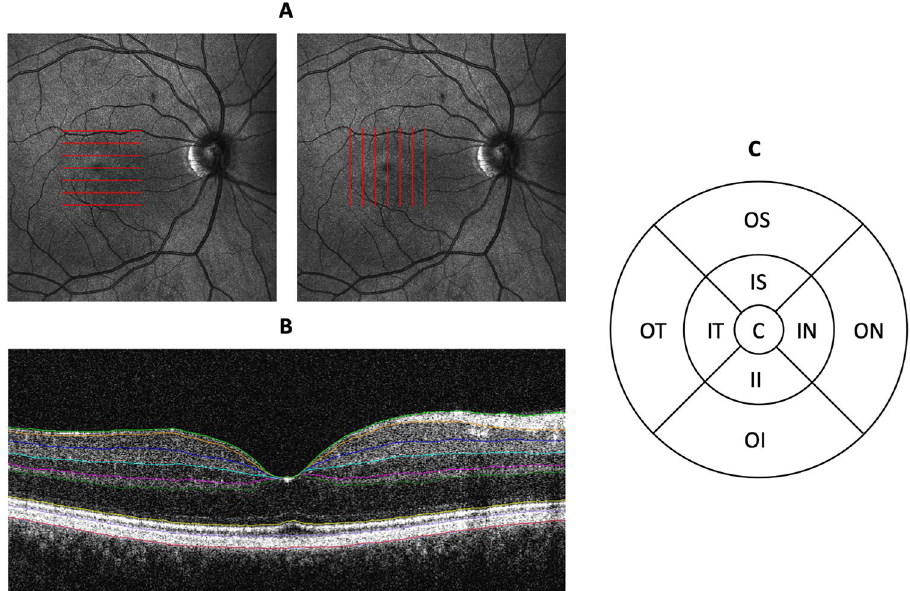
Figure 1. Macular volumetric OCT measurements. ( A ) Schematic representation of the B-scan orientation used in the macular volumetric measurements in the right eye. ( B ) An example B-scan showing the individual retinal layer segmentation. ( C ) Schematic representation of the ETDRS sectors. C central circle, II inner inferior, OI outer inferior, IN inner nasal, ON outer nasal, IS inner superior, OS outer superior, IT inner temporal, OT outer temporal